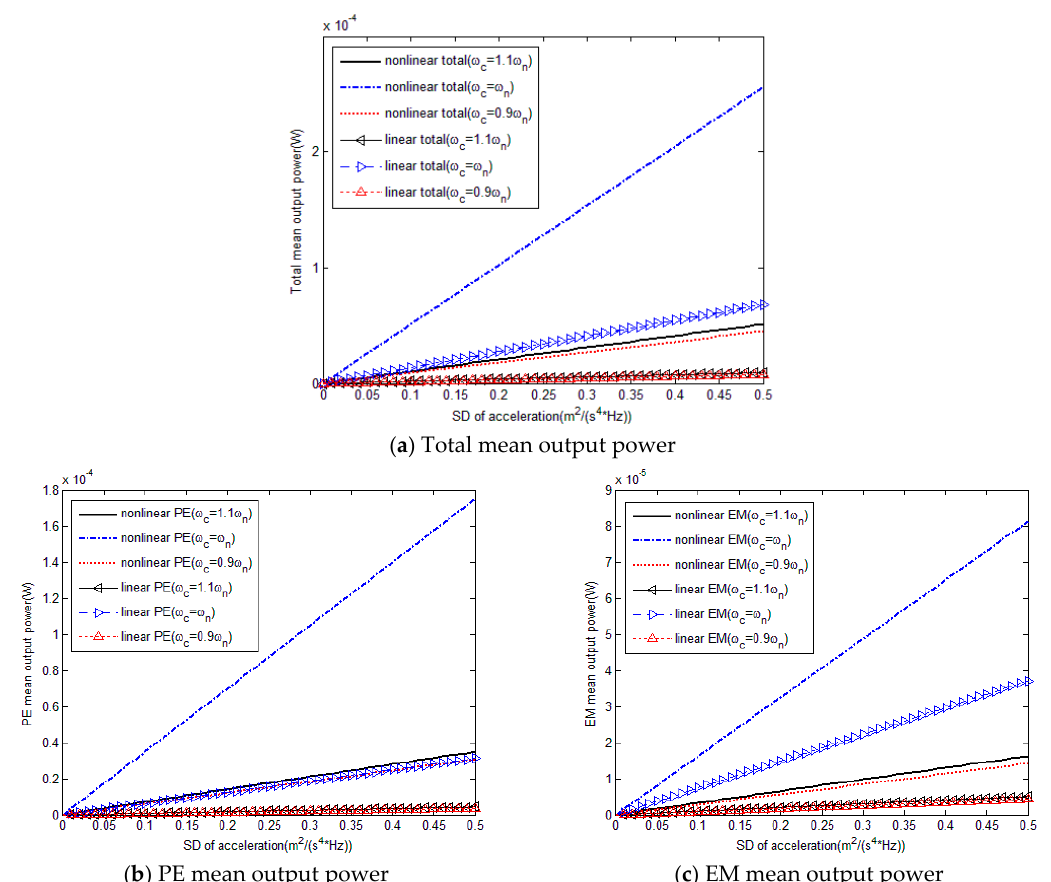
Figure 13. Total mean output power of hybrid energy harvester with load resistance under different center frequencies.